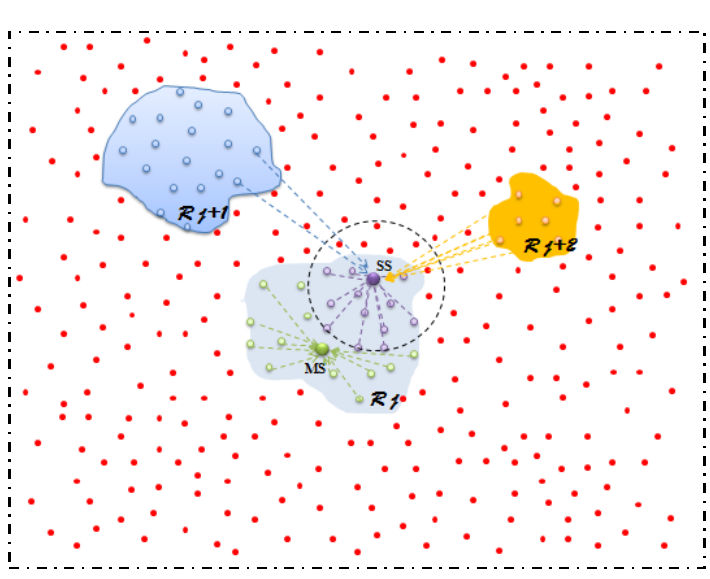
Figure 8. Multi-event